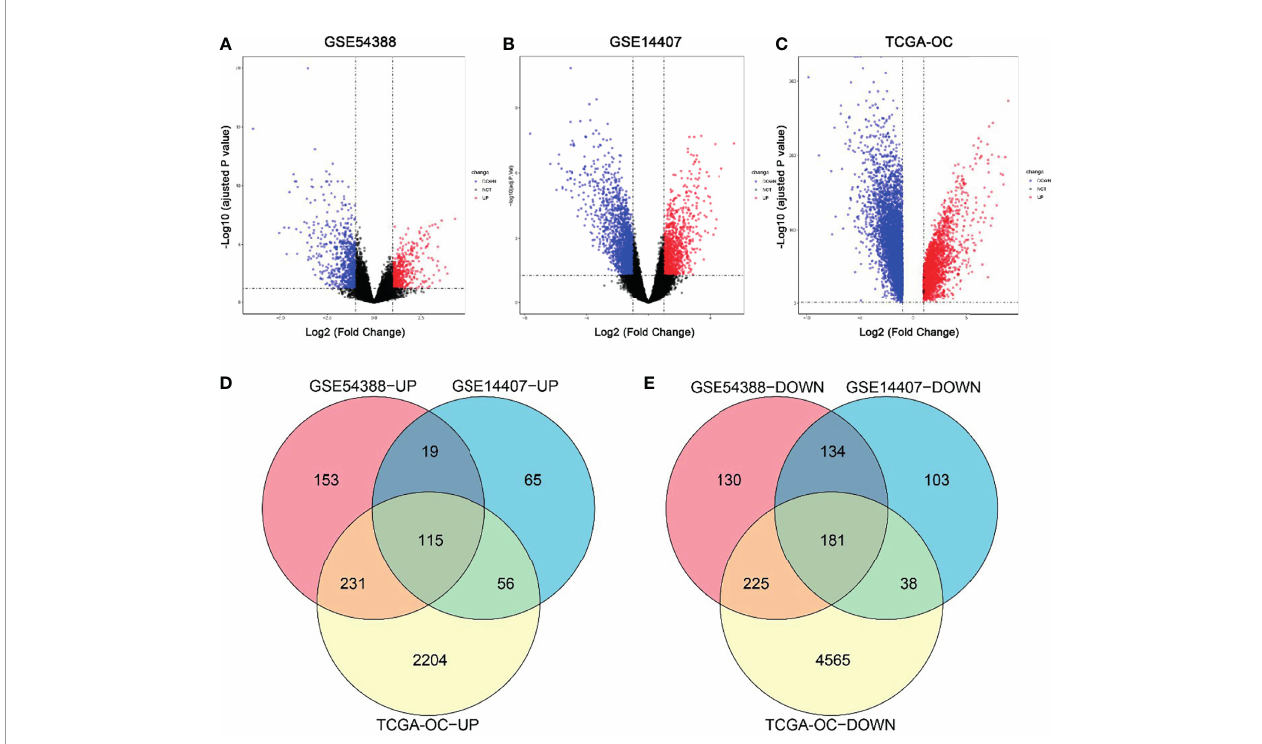
FIGURE 1 | Identi fi cation of common differentially expressed genes (DEGs) in three independent datasets. (A – C) Volcano plot for the DEGs in GSE54388 (A) , GSE14407 (B) , and TCGA-OC (C) datasets when comparing epithelial ovarian cancer (EOC) to normal ovarian subjects. The x-axis represents log2 (fold change), and y-axis represents signi fi cant difference expressed as − log10 (adjusted p-value). DEGs were determined using the limma package. The gene with the adjusted p-value < 0.05,log2FC| ≥ 2 was considered signi fi cant. (D, E) A total of 115 common upregulated genes (D) and 181 common downregulated genes (E) were shared between these three independent